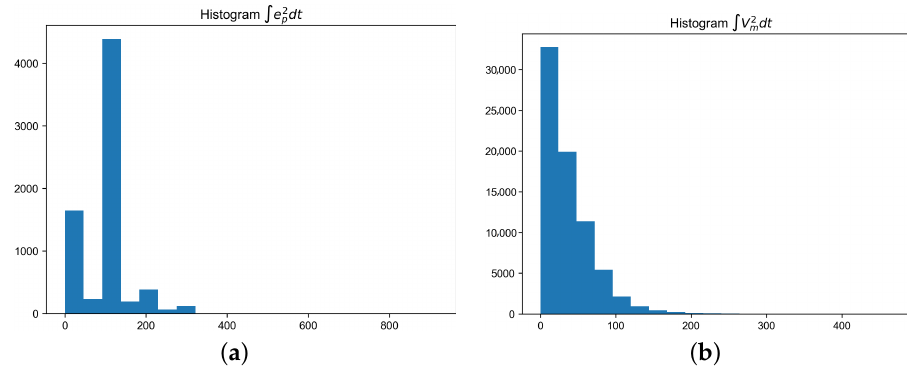
(cid:82) (cid:82) e 2 p dt , ( b ) V 2 m dt .